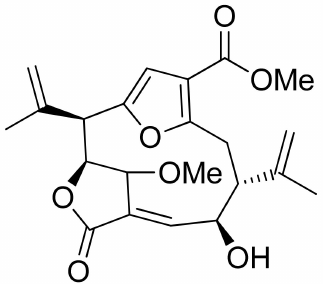
Figure 15. Pseudopterane diterpene